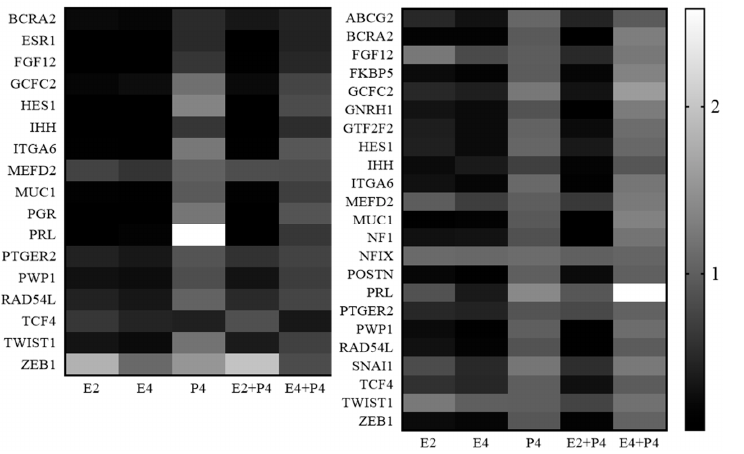
Figure 5. Heatmap of Progesterone receptor pathway RT-qPCR array analysis. Endometriotic cell lines 11Z ( left ) and Hs832 ( right ) were incubated under the following conditions: vehicle 24 h; E2 24 h; E4 24 h; P4 6 h; E2 24 h + P4 6 h; and E4 24 h + P4 6 h. Results are expressed as 2-ddCT.